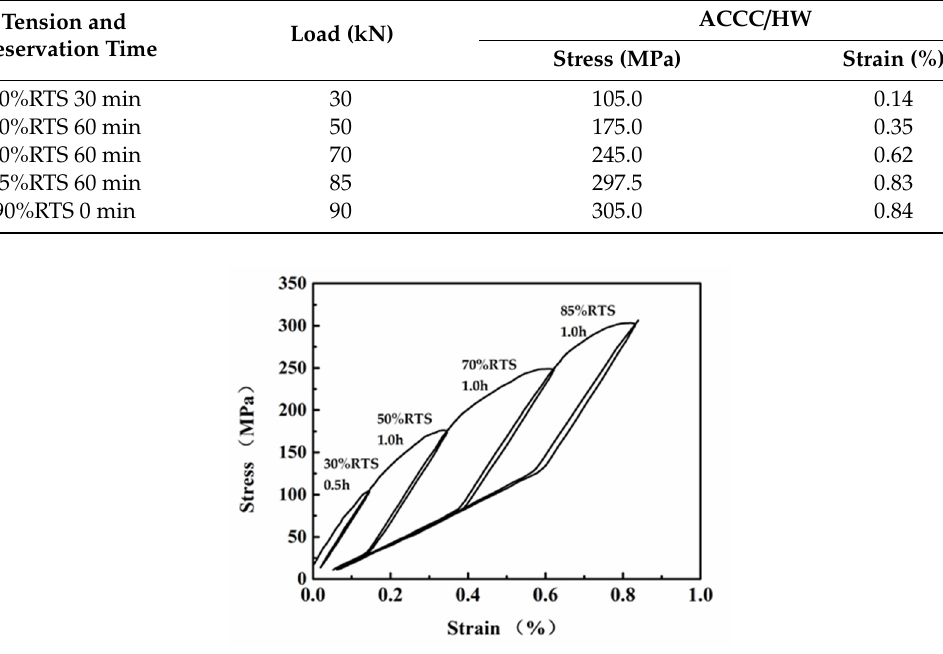
Figure 7. Stress-strain curve of composite core. Aluminum is metal material with elastic deformation and plastic deformation. Therefore, during the whole loading process of ACCC/HW, the aluminum strand has experienced two stages of elastic deformation and plastic deformation. In the first loading process, the curve changes according to the linear law, which indicated that the conductor is at the stage of elastic deformation. When the stress reaches 70 MPa, the curve is out of line, because plastic deformation occurs after the stress of the aluminum strand reaches the elastic limit. The 30% RTS is kept for 30 min. and then unloaded. It can be found that the unloading curve does not coincide with the loading curve, which results from the permanent plastic deformation of aluminum. The second loading process is basically the same as the first loading process. However, the elastic limit of aluminum is increased to 100 MPa because of the strain hardening of metal materials. In the process of unloading, the load of the aluminum strand is at the stage of plastic deformation, and the load is mainly supported by the composite core, so the slope of the unloading curve is larger. When the stress is unloaded to a certain stage, the aluminum strand is recovered to the elastic deformation stage and continues to bear load. The slope of the curve becomes smaller. Therefore, the inflection point occurred at 30 MPa of the stress-strain unloading curve. The third and fourth loading processes are basically the same as that of the second time. The final modulus of ACCC/HW is only 71 GPa, which is slightly lower than the modulus of ACSR. However, Figure 6 obviously shows that the final non-recoverable plastic deformation of ACCC/HW is only 0.5‰, which is much smaller than the non-recoverable deformation of ACSR. Therefore, the safety of ACCC/HW is substantially improved. 3.2. Resistance to Deformation of ACCC/HW